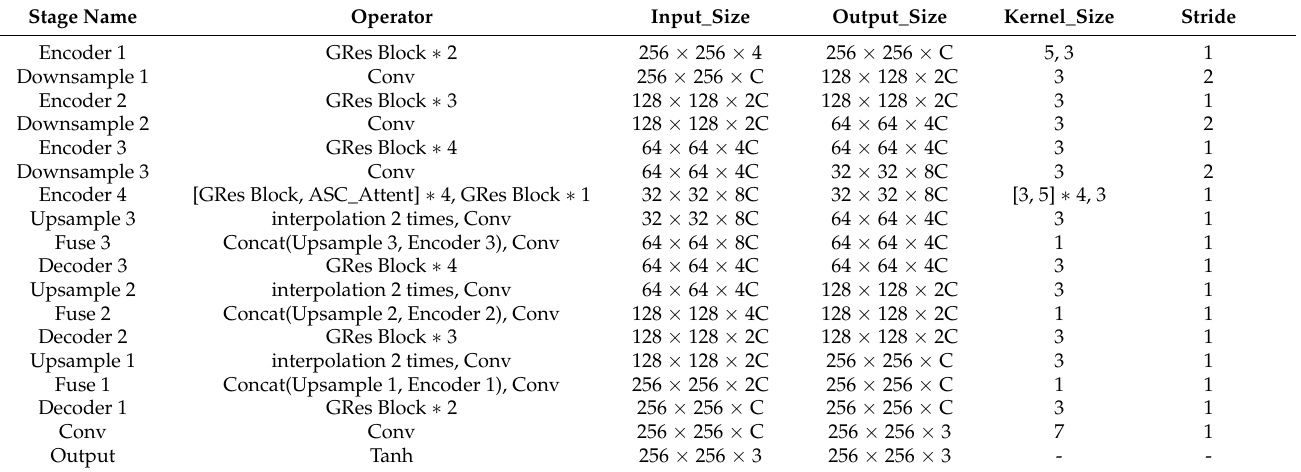
Table 3. Detailed configurations of our AACNet. Input_size consists of height, width, and channel. C represents the number of the basic channel. “ ∗ N ” in operators and kernel_size means reusing the same module or configuration N times. “ × ” denotes multiplication. GRes Block represents the gated residual